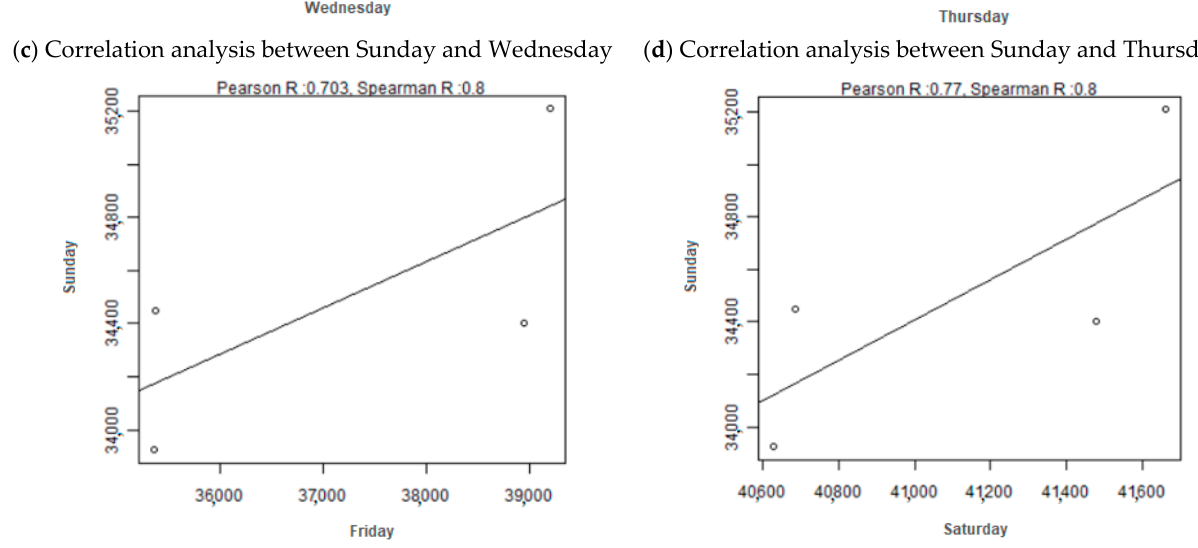
Table 1. Correlation analysis table for each day.